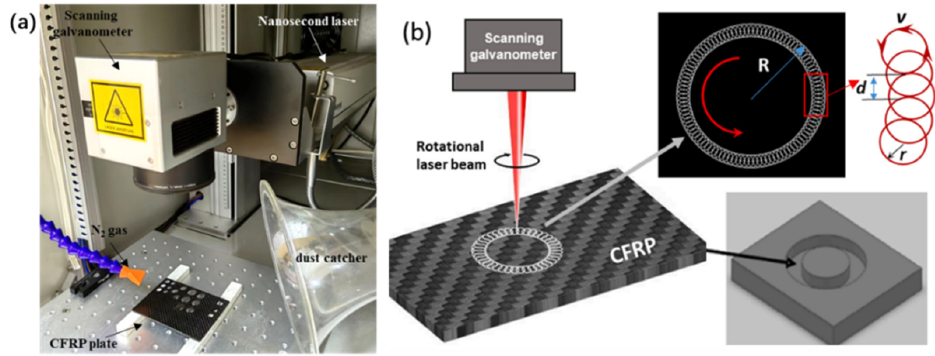
Figure 1. ( a ) The nanosecond laser machining system; ( b ) cutting CFRP with the laser rotary cutting technique [16].